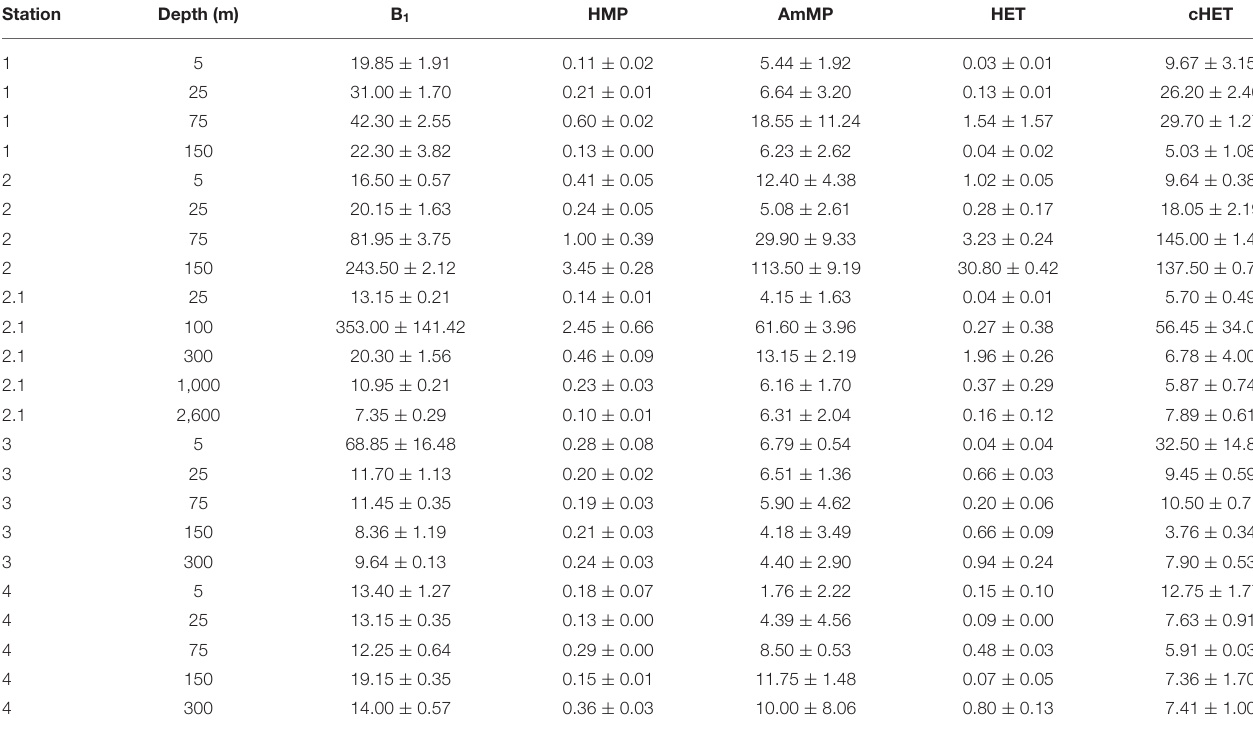
TABLE 2 | Concentrations of dissolved TRCs in picomolar at all stations and depths.